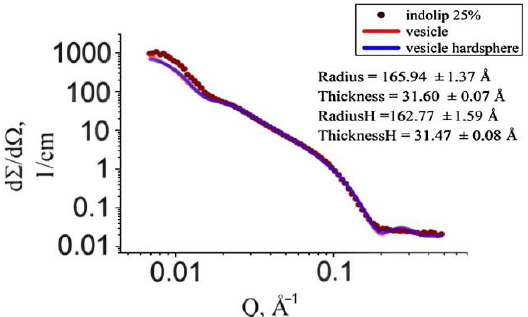
Figure 5. Experimental curve of small-angle neutron scattering of a sample with Indolip concentration of 25% and two approximation functions that describe vesicles taking into account the intervesicle interaction (H) and without it.